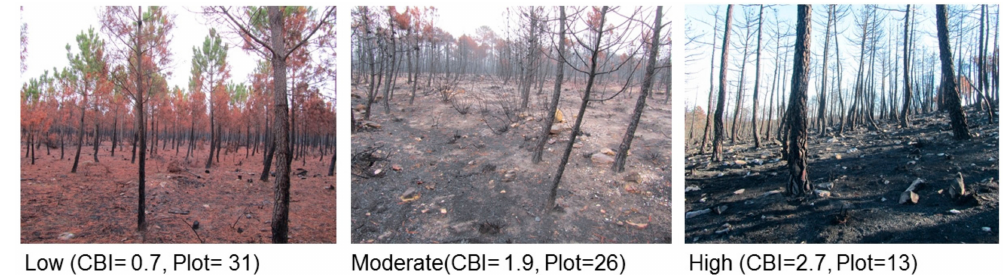
Figure 2. Field photographs depicting the burn severity